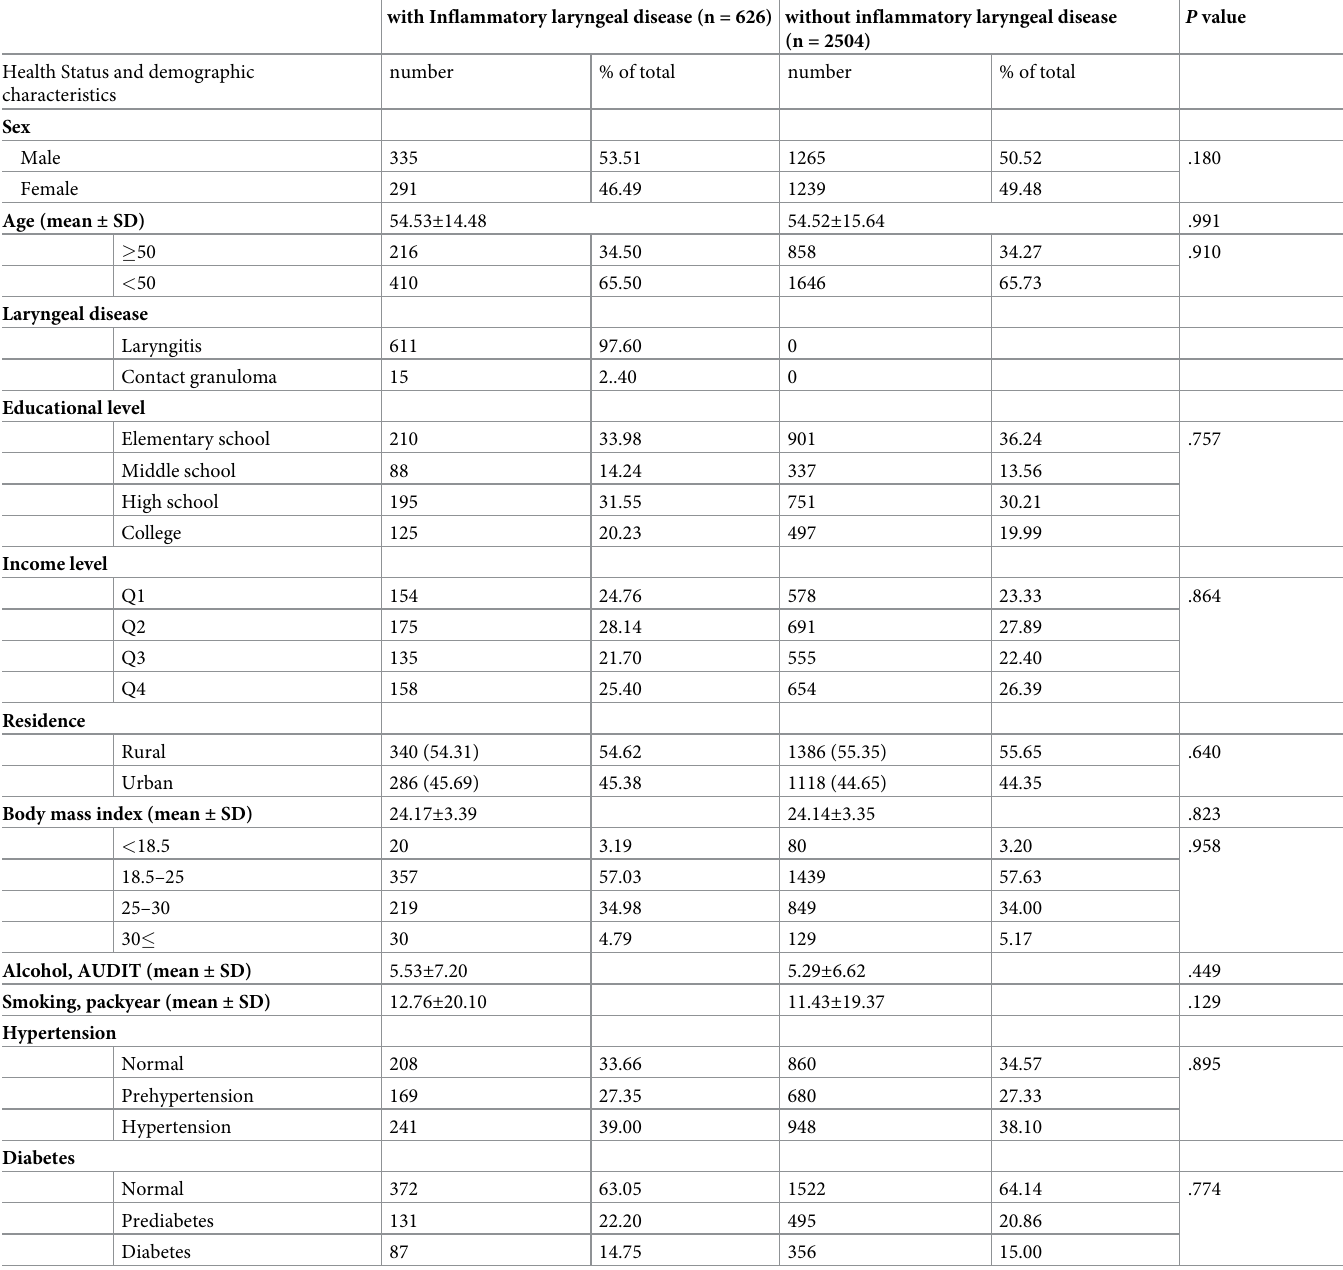
Table 2. Comparison of characteristics of participants with and without ILD after